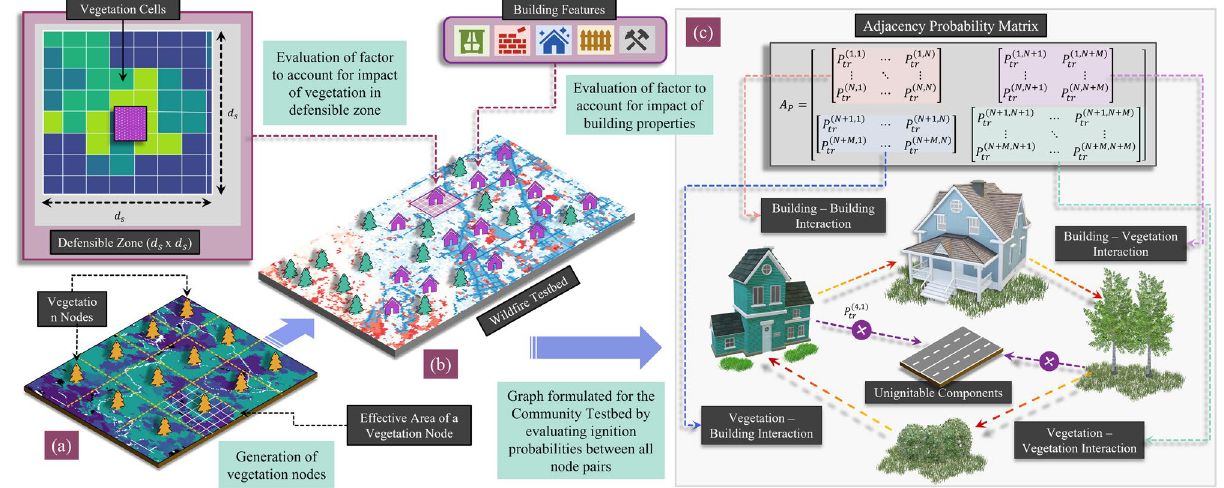
Figure 1. Framework for formulating a graph for a selected wildfire testbed to capture fire interactions between ignitable components within a community. ( a ) Vegetation nodes are formulated from a GIS fuel raster layer ( b ) Building nodes are established for each ignitable structure, and factors are evaluated to account for building properties and vegetation in the defensible zone corresponding to each building node. ( c ) Interactions between all ignitable components (building and vegetation nodes) are realized by formulating an adjacency matrix with edge weights corresponding to the probability of ignition from one node to